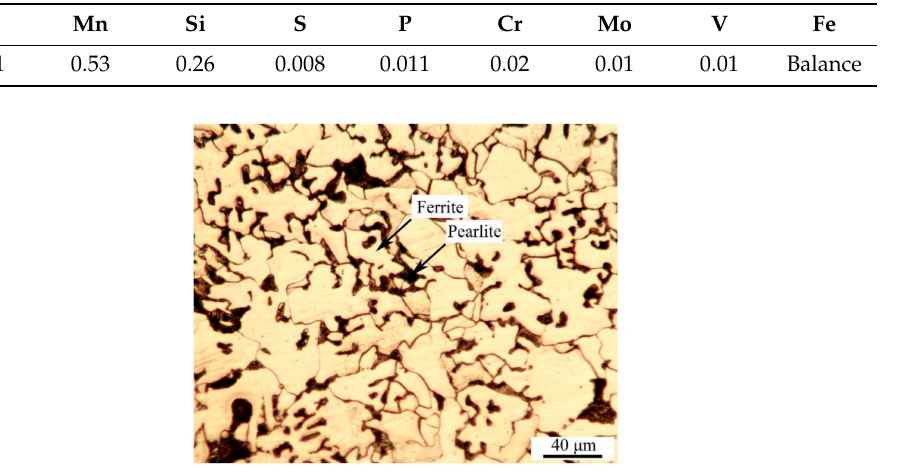
Figure 1. Optical microscope of SA106B low-carbon steel before the rotationally accelerated shot peening